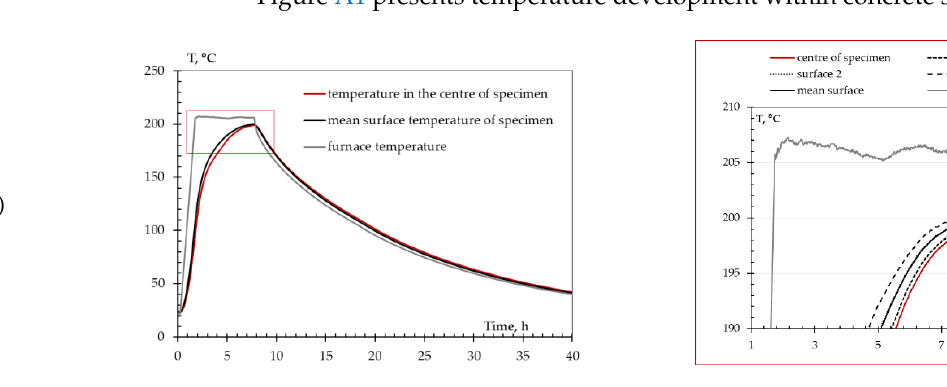
Figure A1. Temperature development for mix M11-LF15 during heating to target temperature of ( a ) 200°C, ( b ) 400°C and ( c ) 600°C. Appendix B. Dolomite Decomposition after Temperature of 800 °C In Figure A2., the degradation of specimens is presented with elapsed time up to 28 days after cooling.